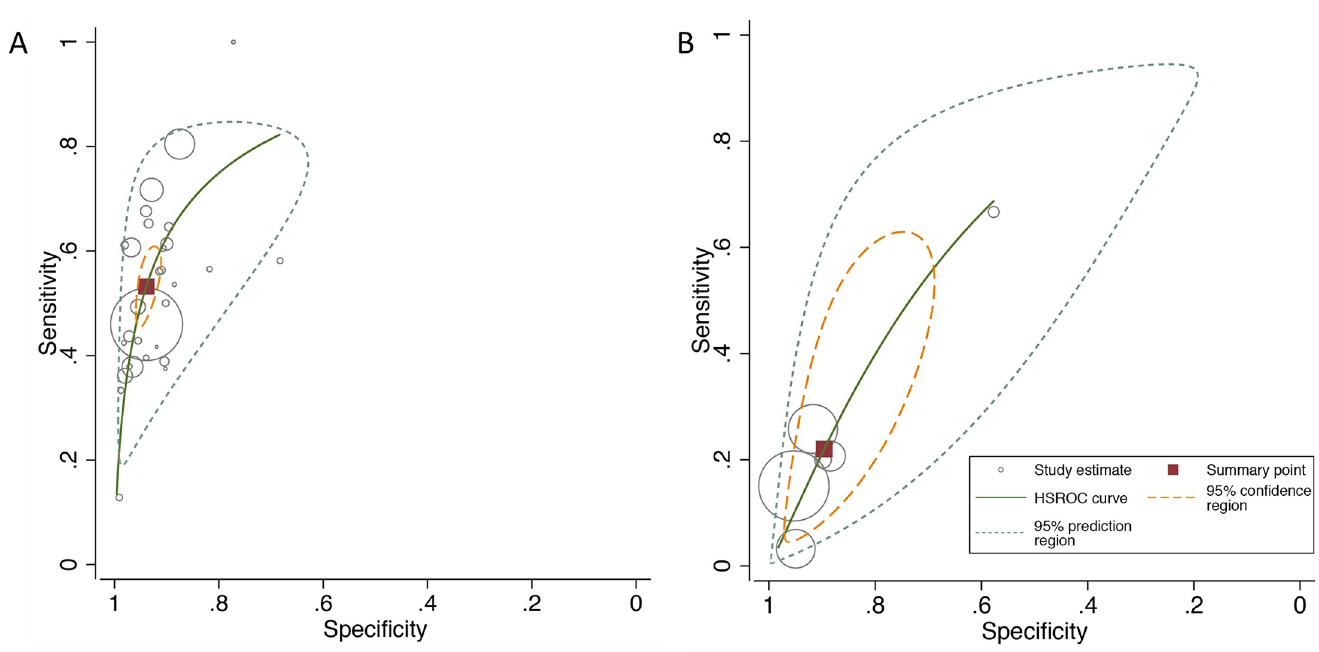
Fig 3. Summary ROC curves for the diagnostic performance of EFW > 4,000 g (or 90th centile) at predicting (A) macrosomia at birth (birthweight above 4,000 g or above the 90th centile) and (B) shoulder dystocia. EFW, estimated fetal weight.